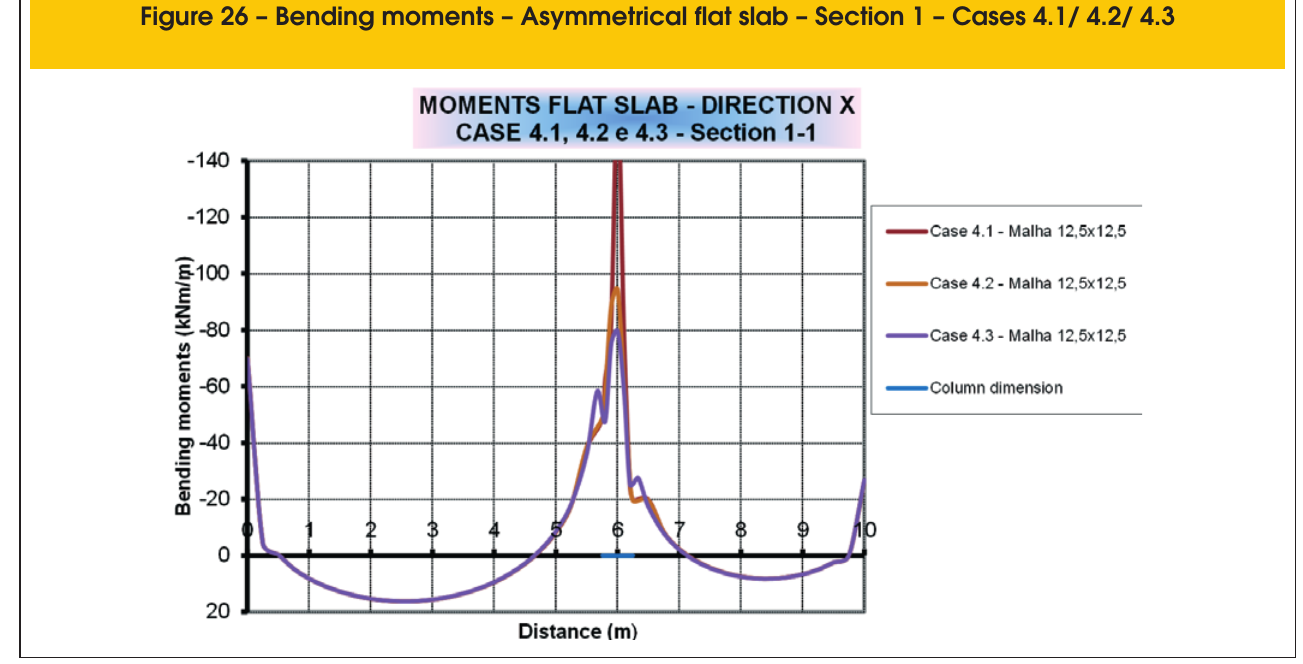
Figure 26 – Bending moments – Asymmetrical flat slab – Section 1 – Cases 4.1/ 4.2/ 4.3